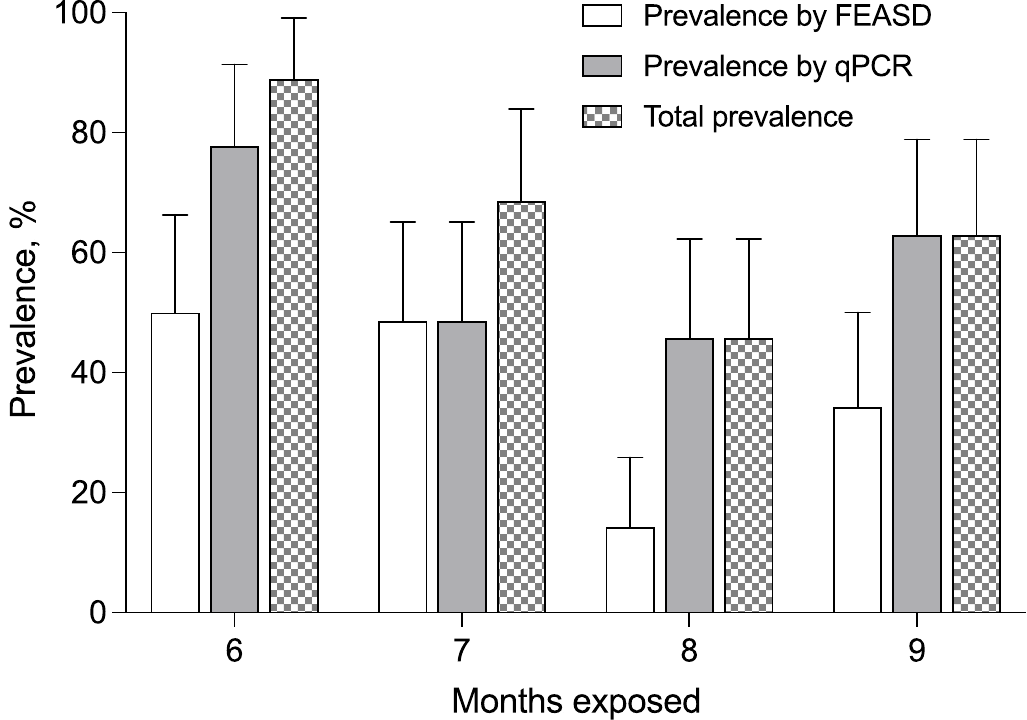
Fig 1. Prevalence of S. japonicum in water buffalo using coprological FEASD and real-time PCR techniques at six to nine months post-natural exposure. Total prevalence incorporates both FEASD & qPCR results. Error bars represent 95% confidence